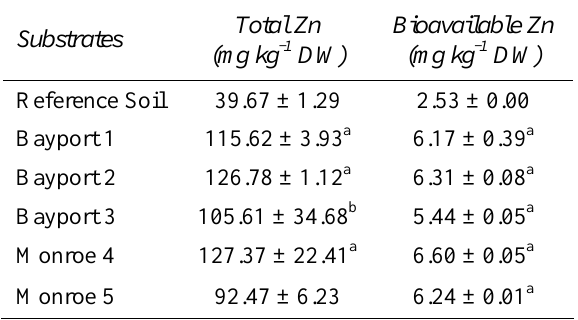
Table 4: Total and bioavailable zinc concentrations (mean values and standard error, N=3).